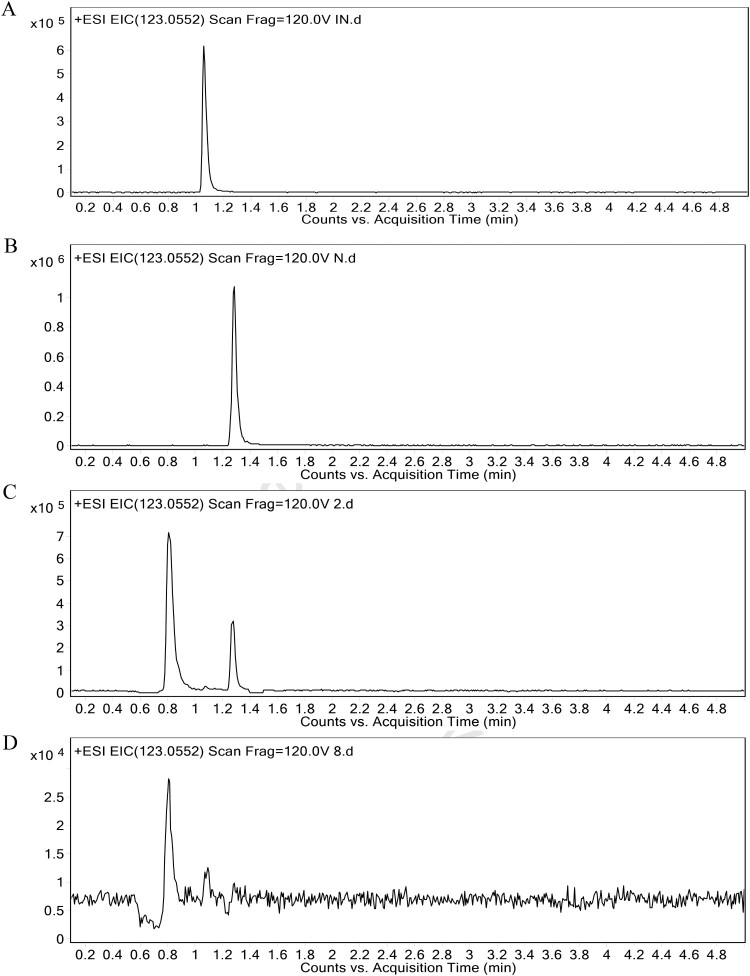
Typical UHPLC-Q-TOF/MS chromatograms of INAM (A), NAM (B), C. albicans SC5314 cells from the untreated (C) or SK-treated group (D). The retention time of INAM and NAM were respectively 1.06 and 1.28 min in UHPLC-Q-TOF/MS chromatogram. INAM, isonicotinamide; NAM, nicotinamide.